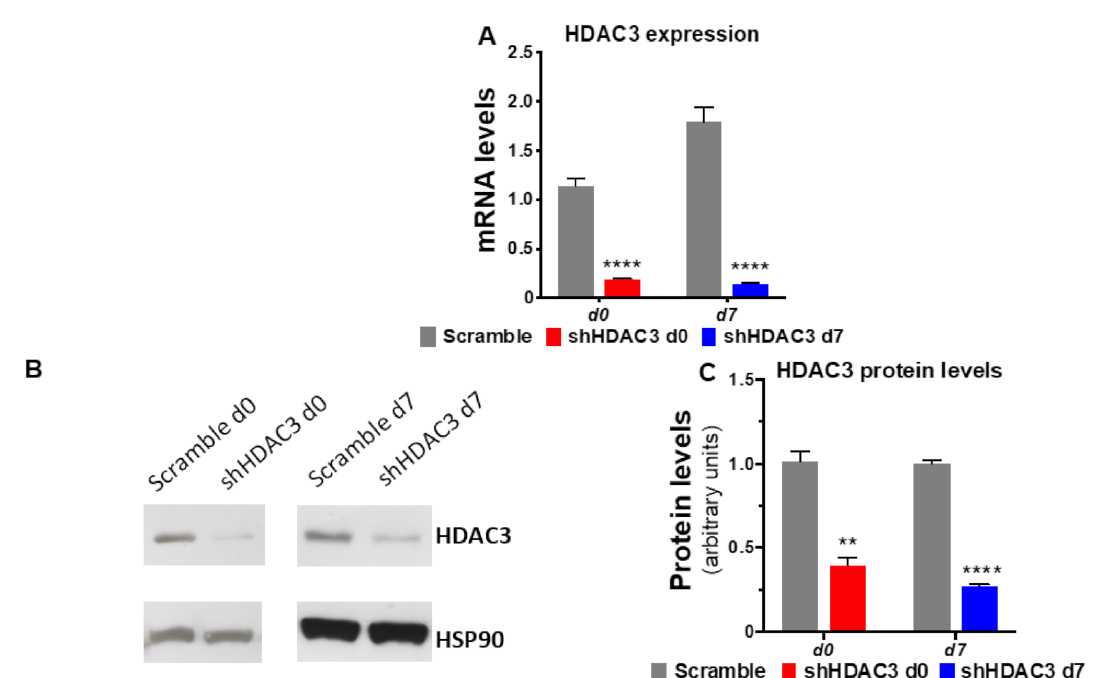
Figure 2. Silencing of HDAC3 confirmed at mRNA and at protein level. ( A ) mRNA expression data are presented as mean ± SEM ( n = 9 from 3 independent experiments). ( B ) Representative western blot of HDAC3 protein levels from three independent experiments. ( C ) Quantitation of HDAC3 protein levels in C3H/10T1/2 adipocytes silenced at day 0 or at day 7 of differentiation ( n ≥ 3 from 3 independent experiments). Cells silenced at day 0 were harvested at day 9 after induction of differentiation, while cells silenced at day 7 were harvested at day 11 after induction of differentiation. Statistical analyses were performed using unpaired Student’s t -test, ** p < 0.01 and **** p < 0.0001,